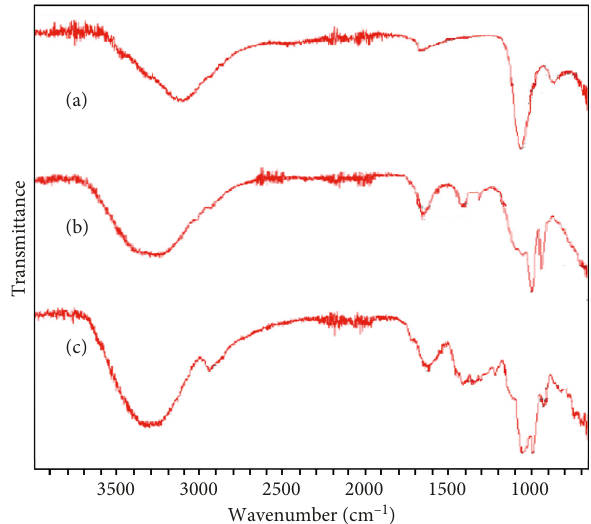
Figure 1: FTIR spectrum of (a) raw WMP, (b) acid-treated WMP, and (c) base-treated WMP.